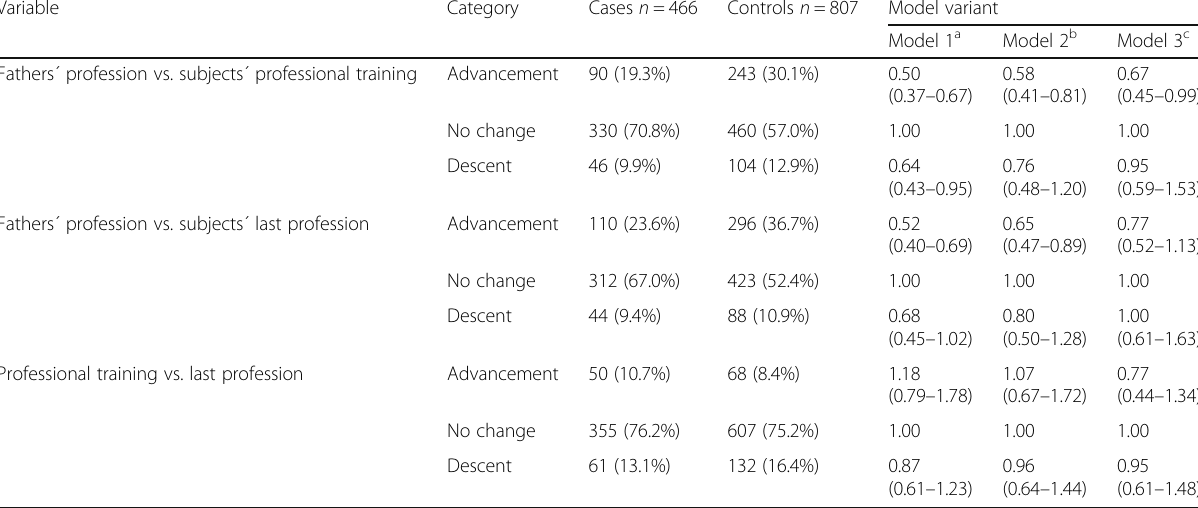
Table 1 Professional status as measure of social mobility between childhood, adolescence and late adulthood